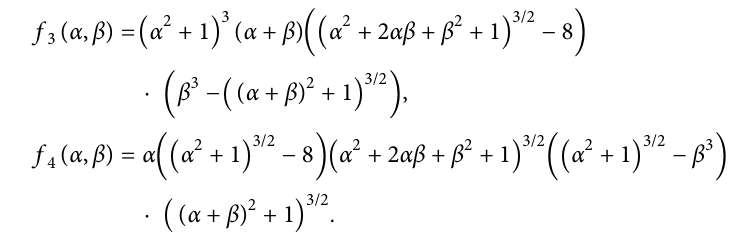
� 0 . 215424, (b) μ 3 � 221 . 3